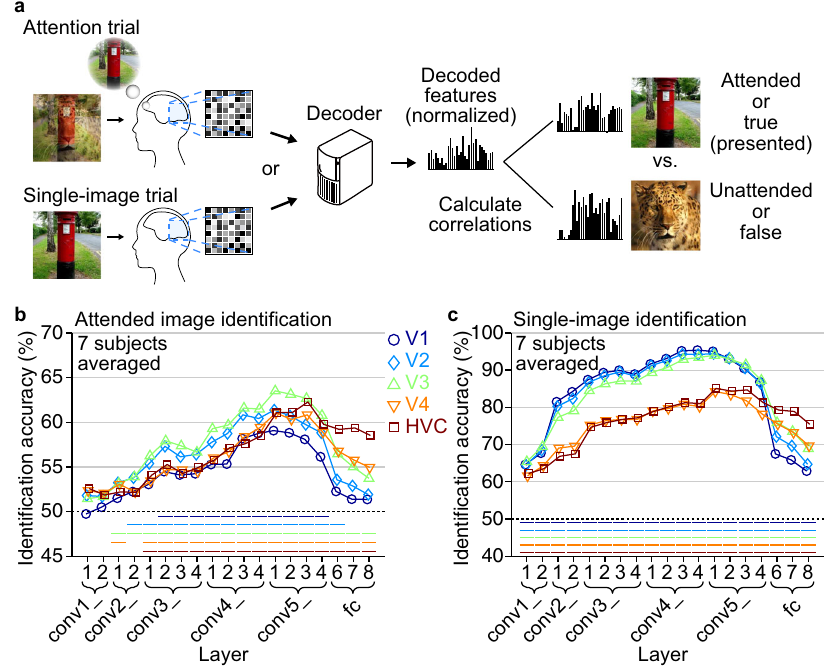
Fig. 4 Identi fi cation by feature correlation. a Identi fi cation procedure. Pair-wise identi fi cation of an attended image or a single presented image was performed via decoded features obtained from each trial (chance level, 50%; normalized by the values in training images for each unit; see Methods: “ Identi fi cation analysis ” ). b Identi fi cation accuracy for attended image reconstructions (averaged across subjects). Mean identi fi cation accuracies are shown for all combinations of individual visual subareas and DNN layers. Statistical analyses were performed with the identi fi cation accuracies across 45 image pairs. Colored lines beneath data indicate the statistical signi fi cance of the difference from the 50% chance level (one-sided t -test, p < 0.01, Bonferroni correction by the numbers of brain areas and DNN layers), in which the power estimated by a post-hoc analysis was higher than 0.8 for all those signi fi cant results. c Identi fi cation accuracy for single-image reconstructions (averaged across subjects). Conventions are the same with Fig. 4b. See Supplementary Figs. 4, 5 for the results of individual subjects with effect